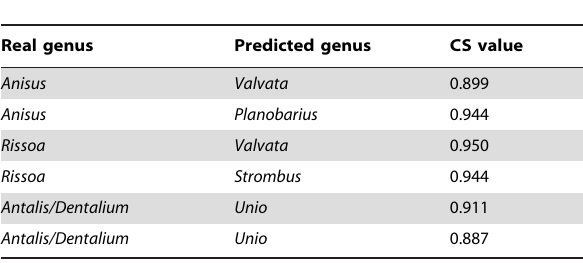
Table 2. Description of ‘‘unclassifiable’’